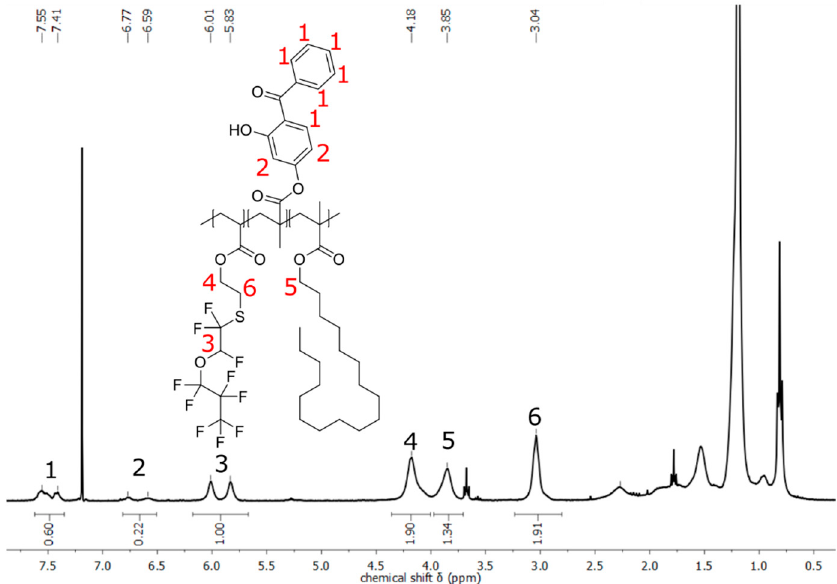
Figure 2. 1 H-NMR spectrum of P(FA- co -StMA- co -BPMA 5% ) measured in hexafluorobenzene and in CDCl 3 . Table 2. List of the proportions of monomers used, as well as the polymerized proportions calculated by 1 H-NMR and DSC.